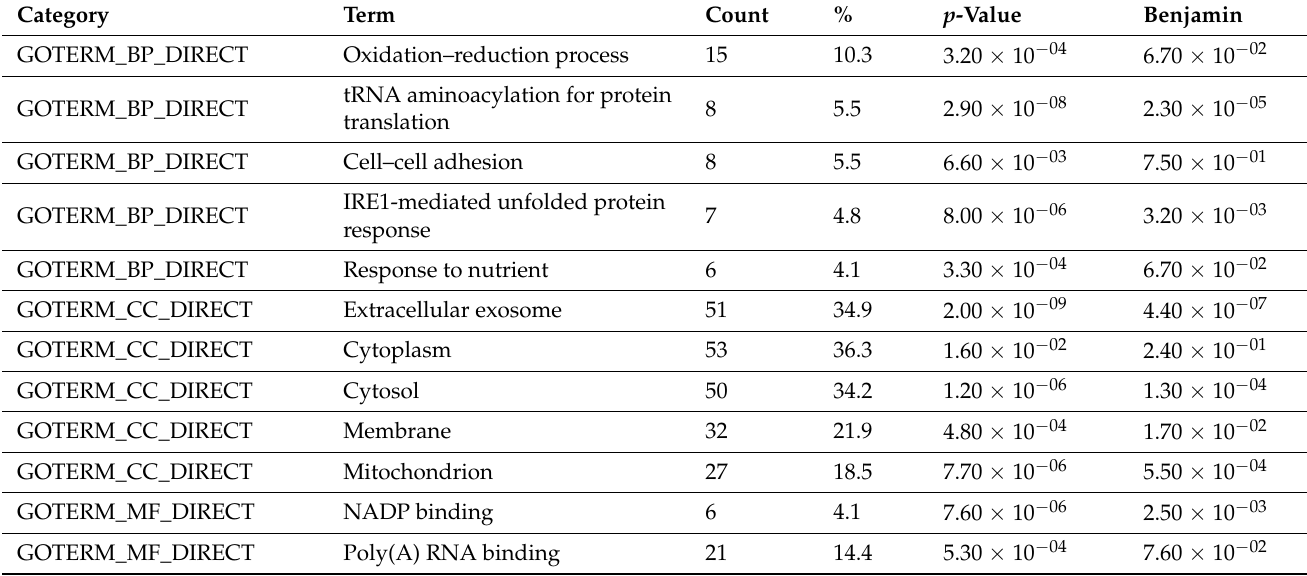
Table 4. Top five gene ontology (GO) terms and Kyoto Encyclopedia of Genes and Genomes (KEGG) pathways enriched for downregulated